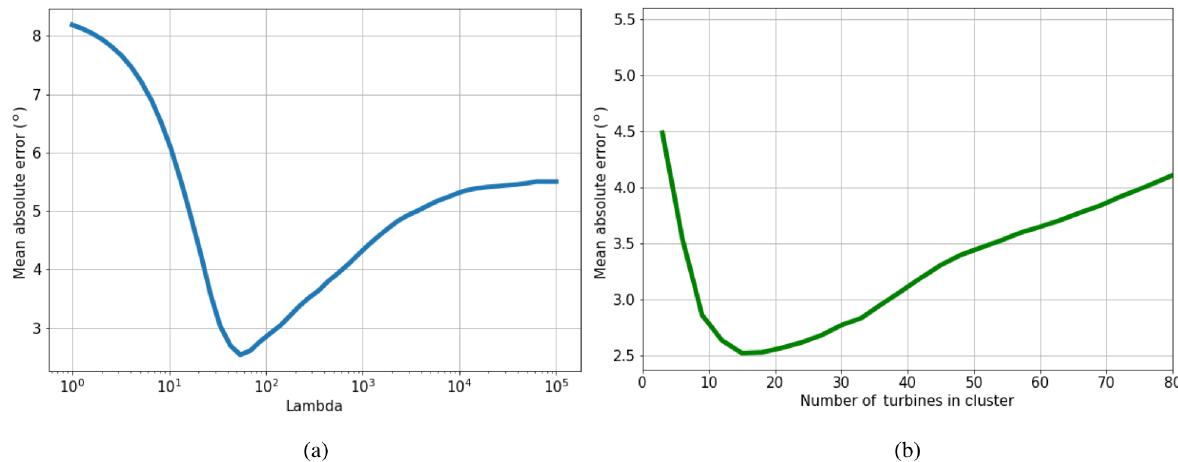
Figure 5. (a) This subplot shows the mean absolute error computed with consensus using a range of penalty parameters, λ . (b) The cluster size was varied and resulting mean absolute error calculated to understand the best number of turbines to communicate with.